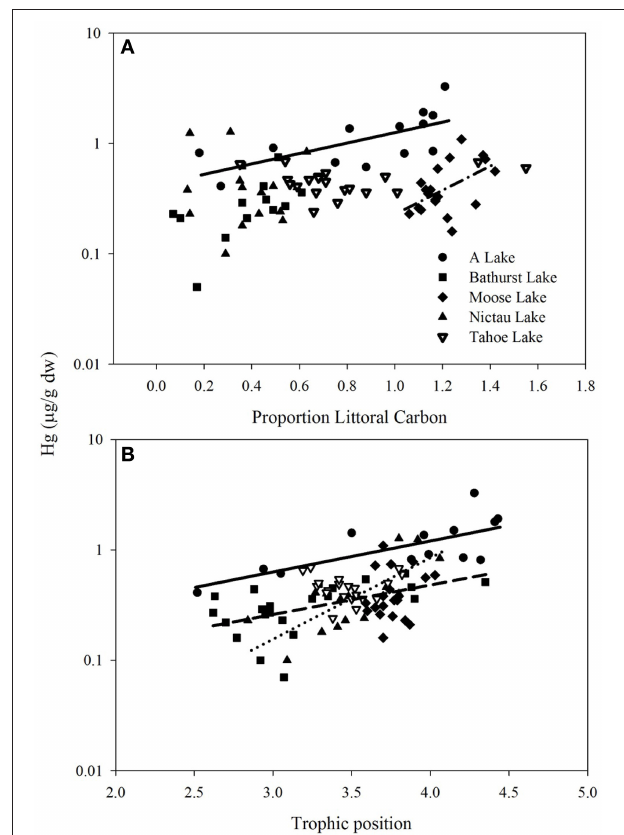
FIGURE 1 | Total Hg ( µ g/g ww) vs. (A) proportion littoral carbon and (B) trophic position (see Methods for calculations) in Brook Trout from five lakes in New Brunswick, Canada. Regression lines are shown where relationships were significant. A Lake (solid line log Hg = − 0.368 ± 0.147 + 0.467 ± 0.159 C, p = 0.014, r 2 adj = 0.38; log Hg = − 1.058 ± 0.315 + 0.285 = 0.48), Moose Lake (dash-dot line, log Hg = ± 0.0814 TP, p = 0.005, r 2 adj − 1.721 ± 0.522 + 1.082 ± 0.431 C, p = 0.04, r 2 = 0.22), Nictau adj